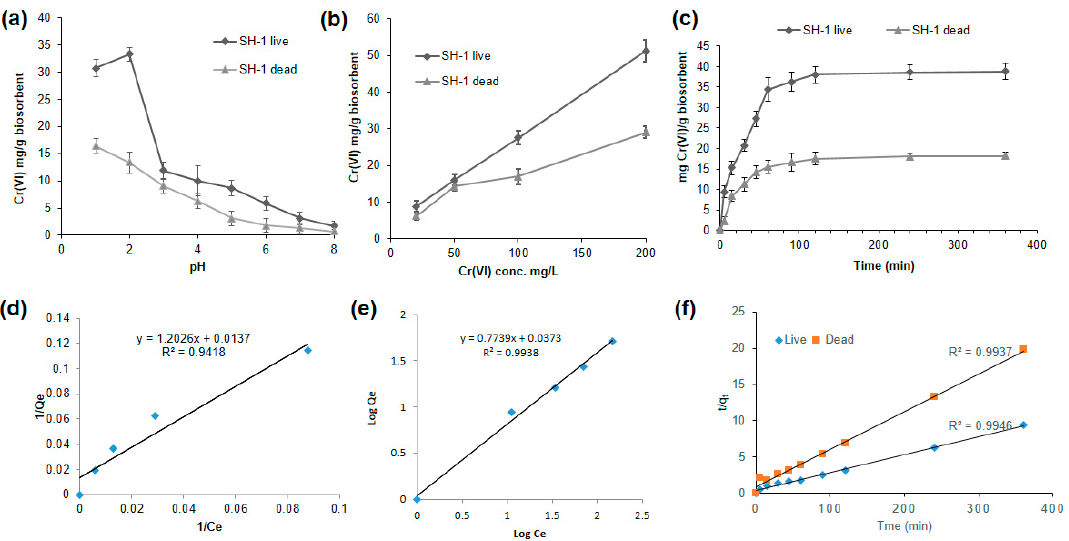
Figure 3. Biosorption assay of isolates, adsorption model, and kinetics. ( a ) Effect of pH and ( b ) initial concentration of Cr(VI) on biosorption process. ( c ) Effect of contact time on biosorption process. ( d ) Langmuir isotherm model and ( e ) Freundlich isotherm model for SH-1 live biomass. ( f ) Pseudo-second-order kinetics plots for biosorption of Cr(VI) by live and dead bacterial biomass.